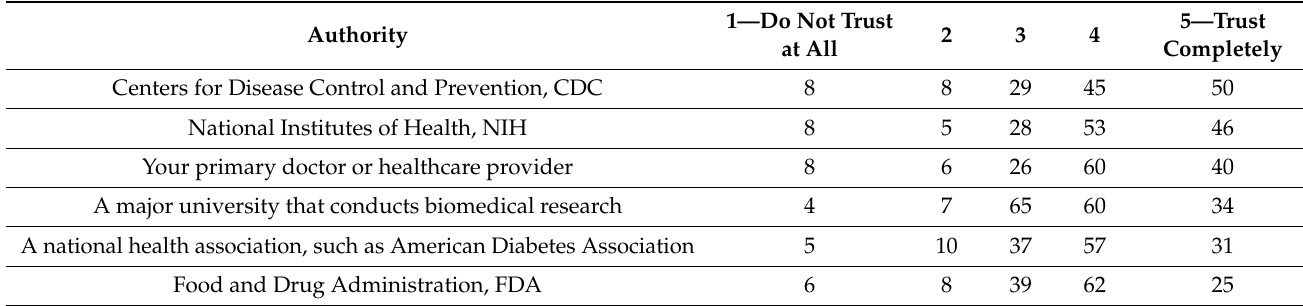
Table 8. Trust in public health authority